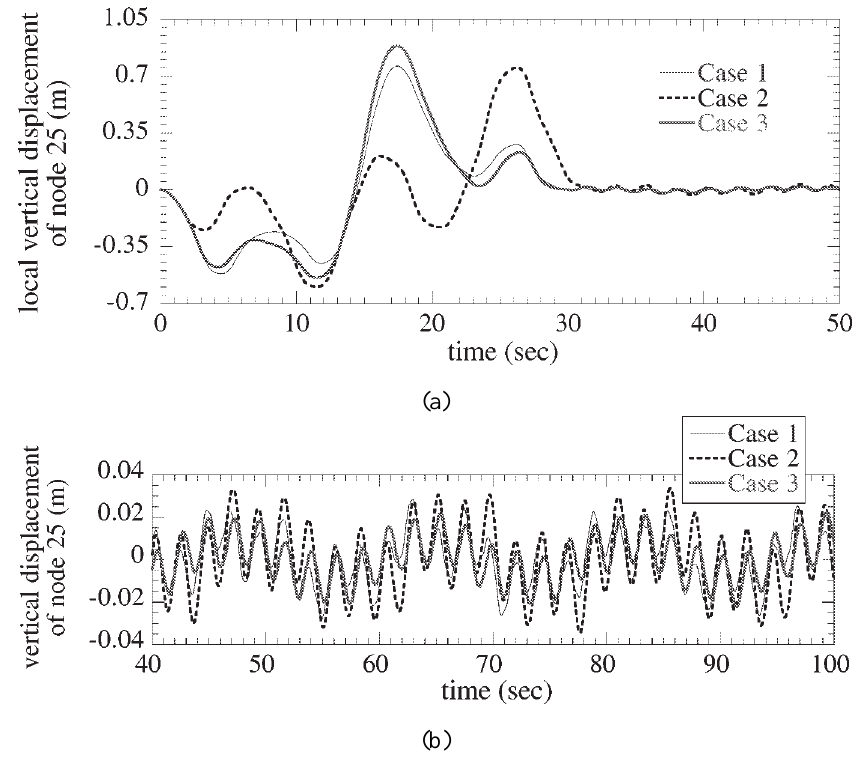
Fig. 11. Time responses of local vertical displacement of node 25 of solar panel: (a) during maneuver, (b) residual vibration.